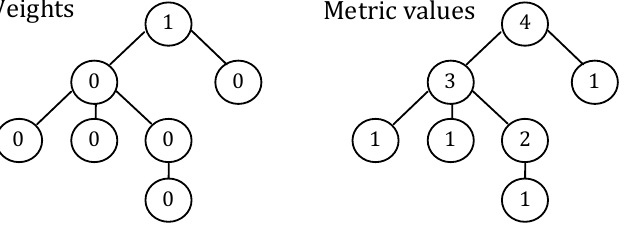
Fig 8. Calculation of the “height of the tree” as a node-based sentence metric. In this example the result is 0x1+0x3+0x1+0x1+1x4+0x1+0x2=4.